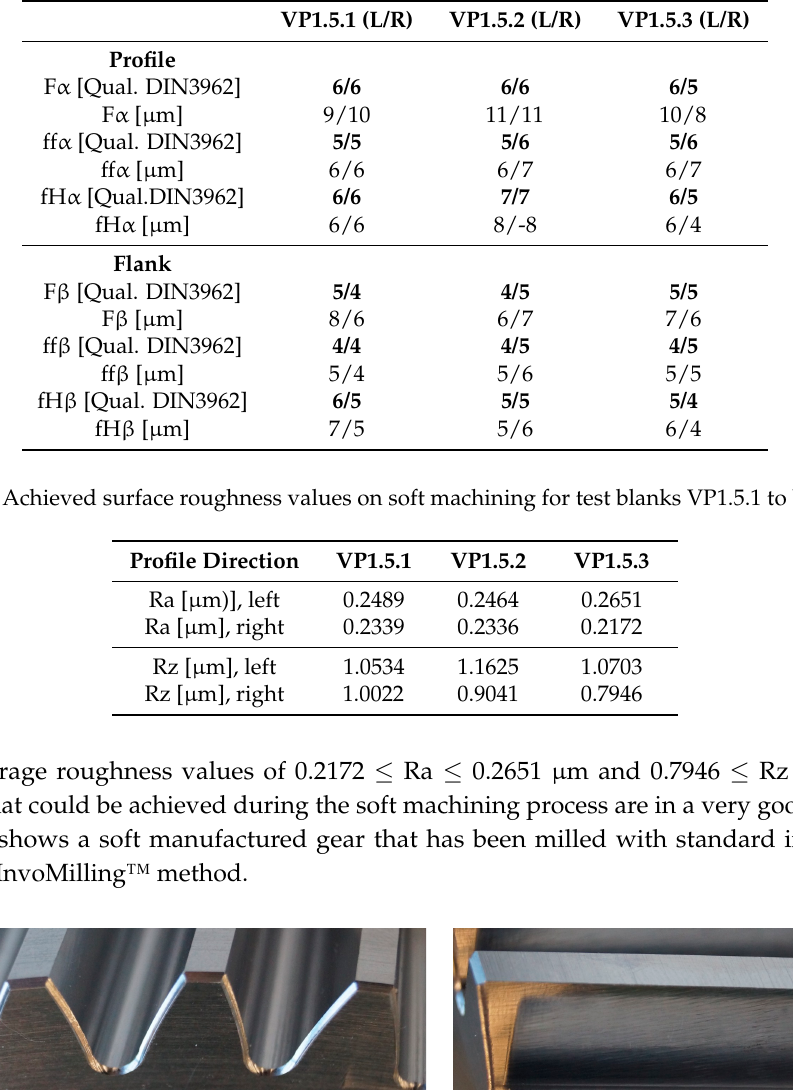
Table 4. Achieved gear quality according to DIN 3962 [18] of soft machining for test blanks VP1.5.1 to VP1.5.3.